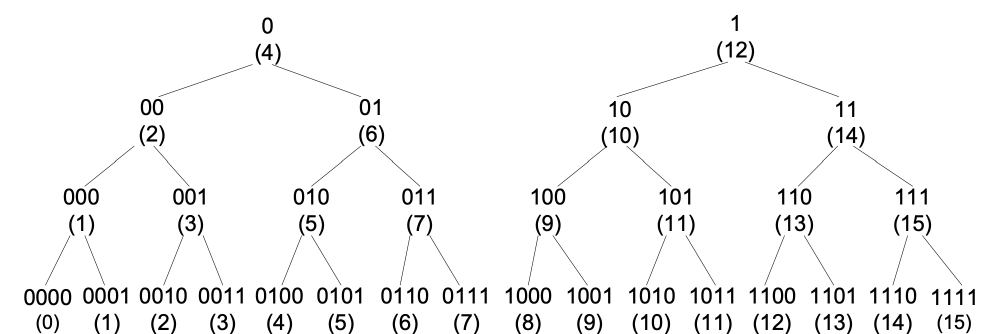
Figure 3. Tree structures of binary strings and their integer values decoded between 0 and 15.